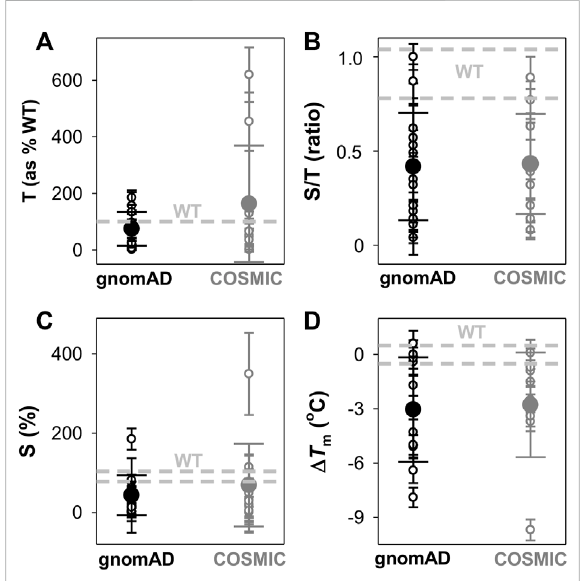
FIGURE 3 Overall effects of gnomAD and COSMIC variations on the solubility/aggregation propensity and thermal stability of the NQO1protein. (A – C) Expressionanalysesofsolubility/aggregation propensity of NQO1 variants in E.coli at 37 o C. The total amountofNQO1protein[T, (A)] aswellastheratioofsoluble/total (S/T) protein (B) were determined from induced cells sonicated before (T) and after (S) centrifugation at 21,000 g . The levels of NQO1 protein were determined by western-blotting (Supplementary Figure S3). The amount of soluble protein (S) is calculated as the product of T and S/T and shown in (C) . Data are the mean ± s.d. from at least three independent expression experiments for each variant; (D) Thermal stability of NQO1 variants as holo-proteins. Δ T m values correspond to the difference between a given variant and the WT protein. Data are the mean ± s.d. from three-six technical replicas. Small circles indicate the effects of individual variants and large circles (and correspondingerrors)arethoseforeachdataset(mean±s.d.).For reference, the values corresponding to WT NQO1 are shown in light grey. Variants are grouped in the gnomAD and COSMIC